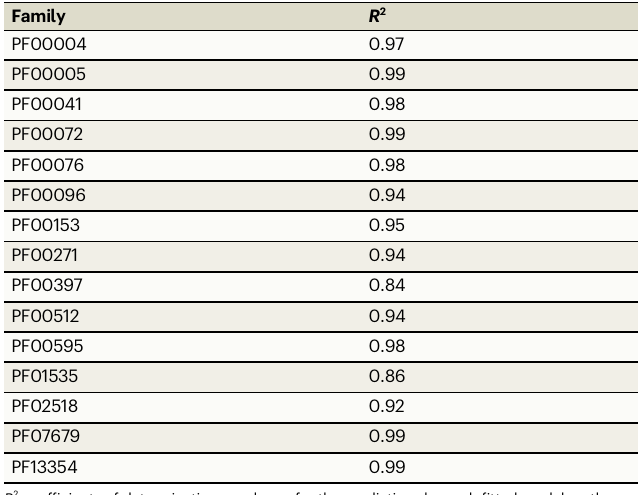
Table 1 | Quality of fi t for logistic models trained to predict Hamming distances separately in each